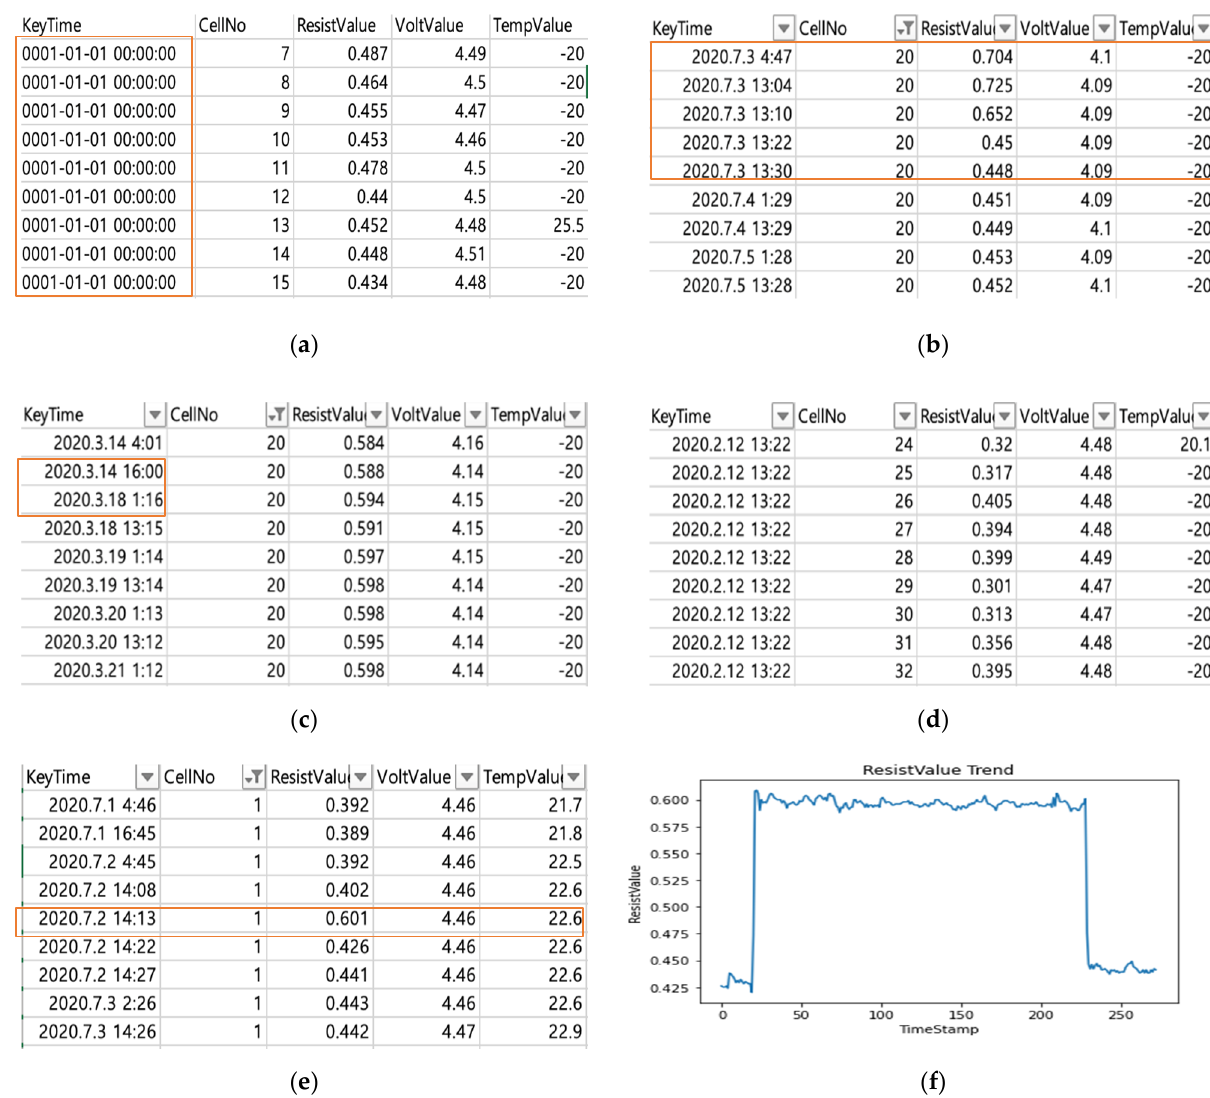
Figure 2. Steps for data preprocessing . ( a ) Step 1. Delete KeyTime(DateTime) error; ( b ) Step 2. Delete